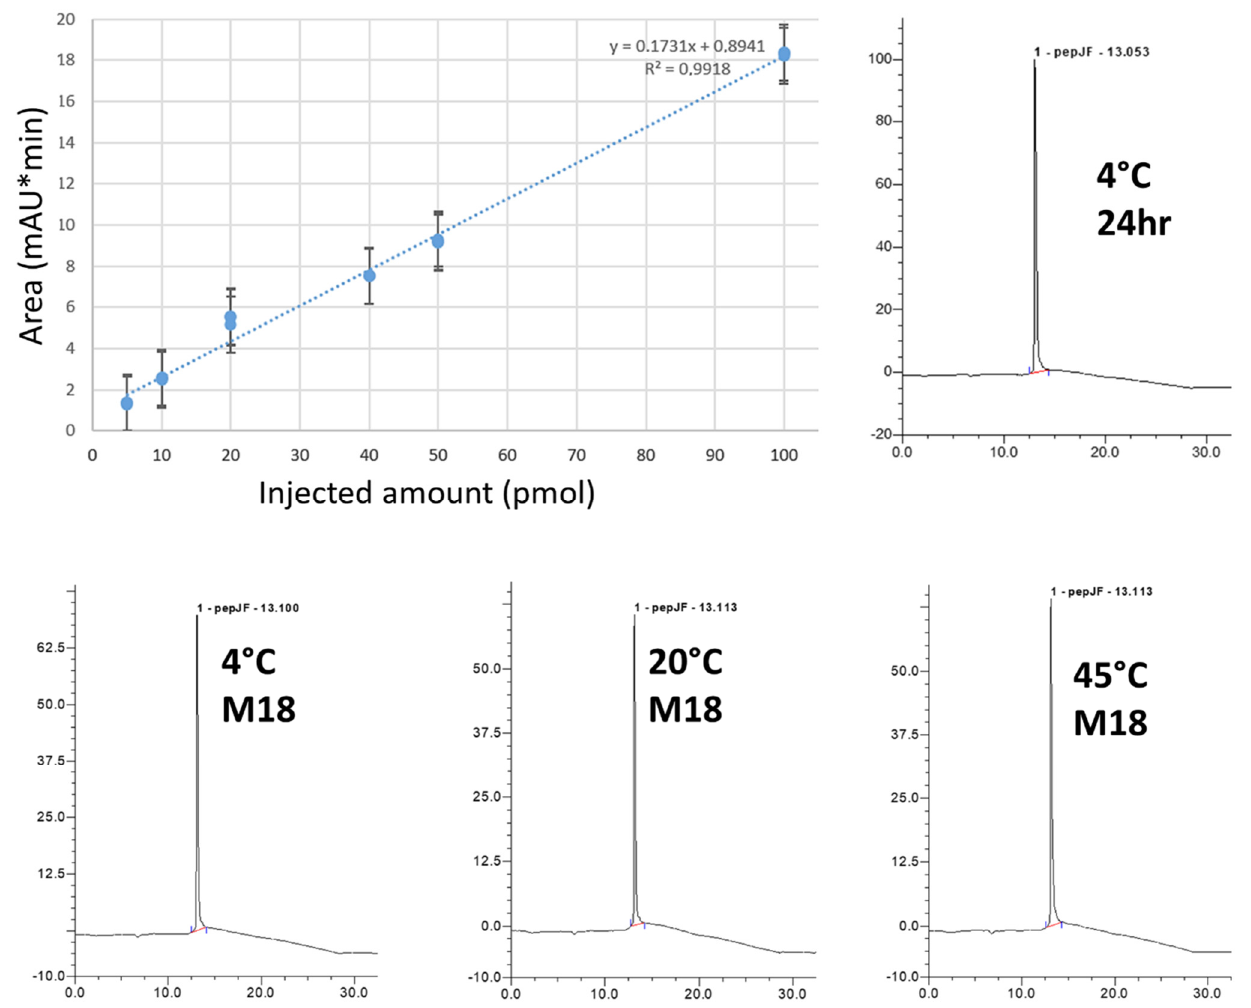
Figure 2. Chemical stability of AmyP53 in aqueous solution. AmyP53 was dissolved in pure water at a concentration of 1 mM and stored for 18 months at 4 °C, 20 °C, and 45 °C. The calibration curve (upper left) is linear over the 5–100 pmol range (R 2 > 0.99). The minimal amount detected is 5 pmol. Representative original raw HPLC spectra at 24 h (upper right) and M18 (18-month, lower panels) are shown.